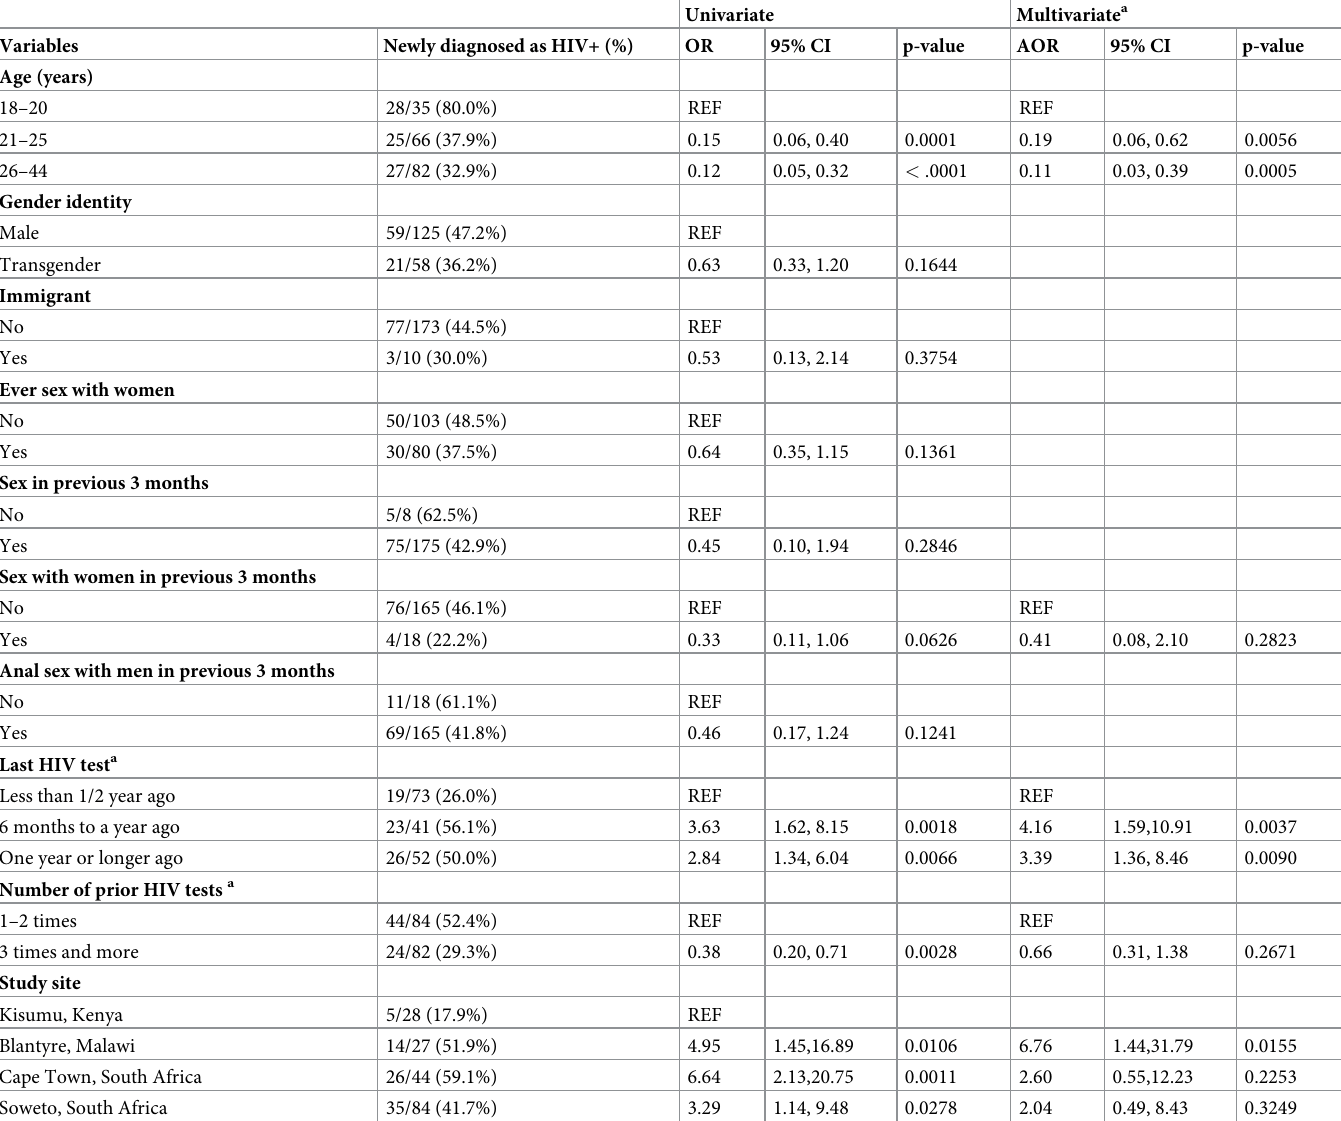
Table 5. Characteristics of MSM and TW with newly diagnosed vs. previously diagnosed HIV infections who were screened for participation in HPTN 075 (N =